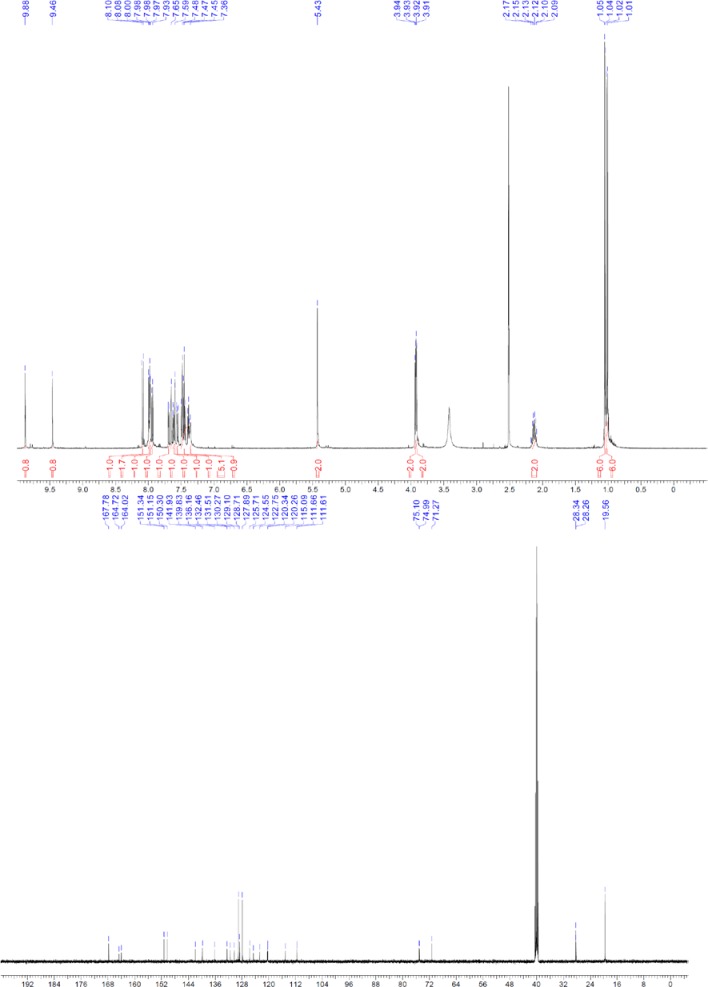
1H and 13C NMR of ERX-13.